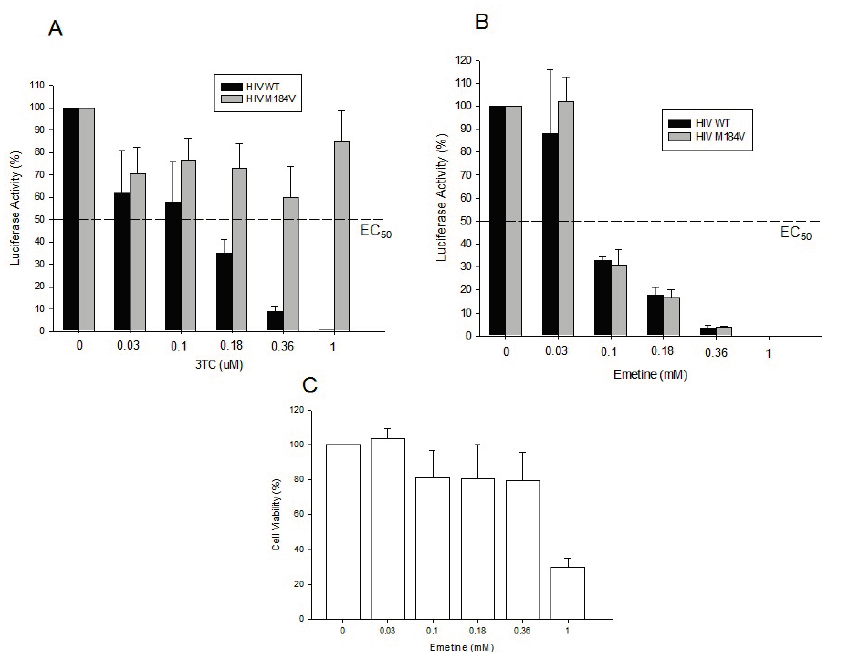
Figure 3. Emetine inhibits HIV wild type and HIV M184V replication in GHOST Cells. ( A ) Resistance profile of HIV WT and HIV M184V in GHOST cells in the presence of 3TC; ( B ) GHOST cells were infected with HIV WT and HIV M184V in the presence of emetine. The HIV infectivity was evaluated by luciferase activity 48 h post-infection from the cell lysates; ( C ) Cytotoxicity effects of emetine were evaluated using fluorescent live/dead staining. All the results are shown in percentage relative to positive controls corresponding to cells not exposed to emetine. Here we present the means and standard deviations of three independent experiments with internal triplicates. The EC 50 representative value is shown in the